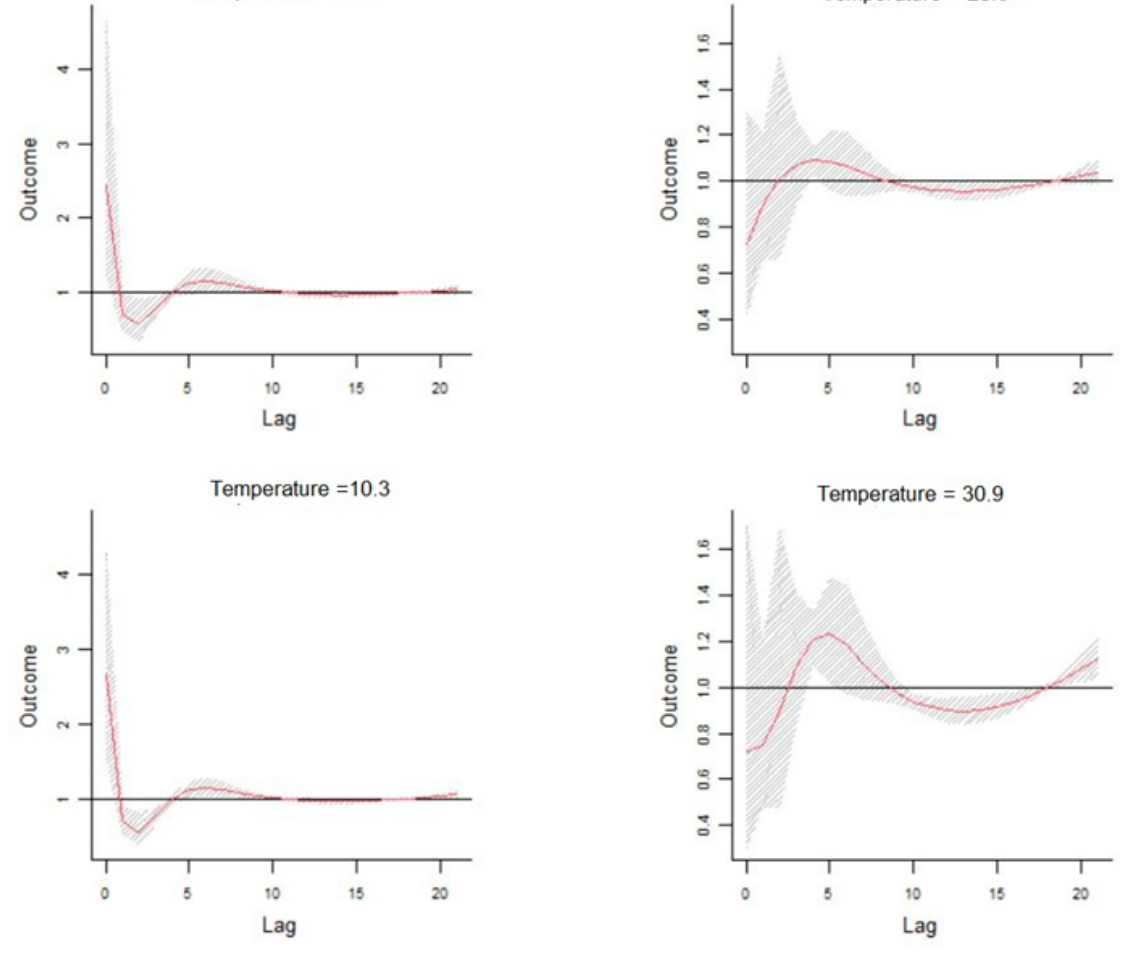
Figure 9. Dose–response curve cumulative effects of temperatures at different time-lags.